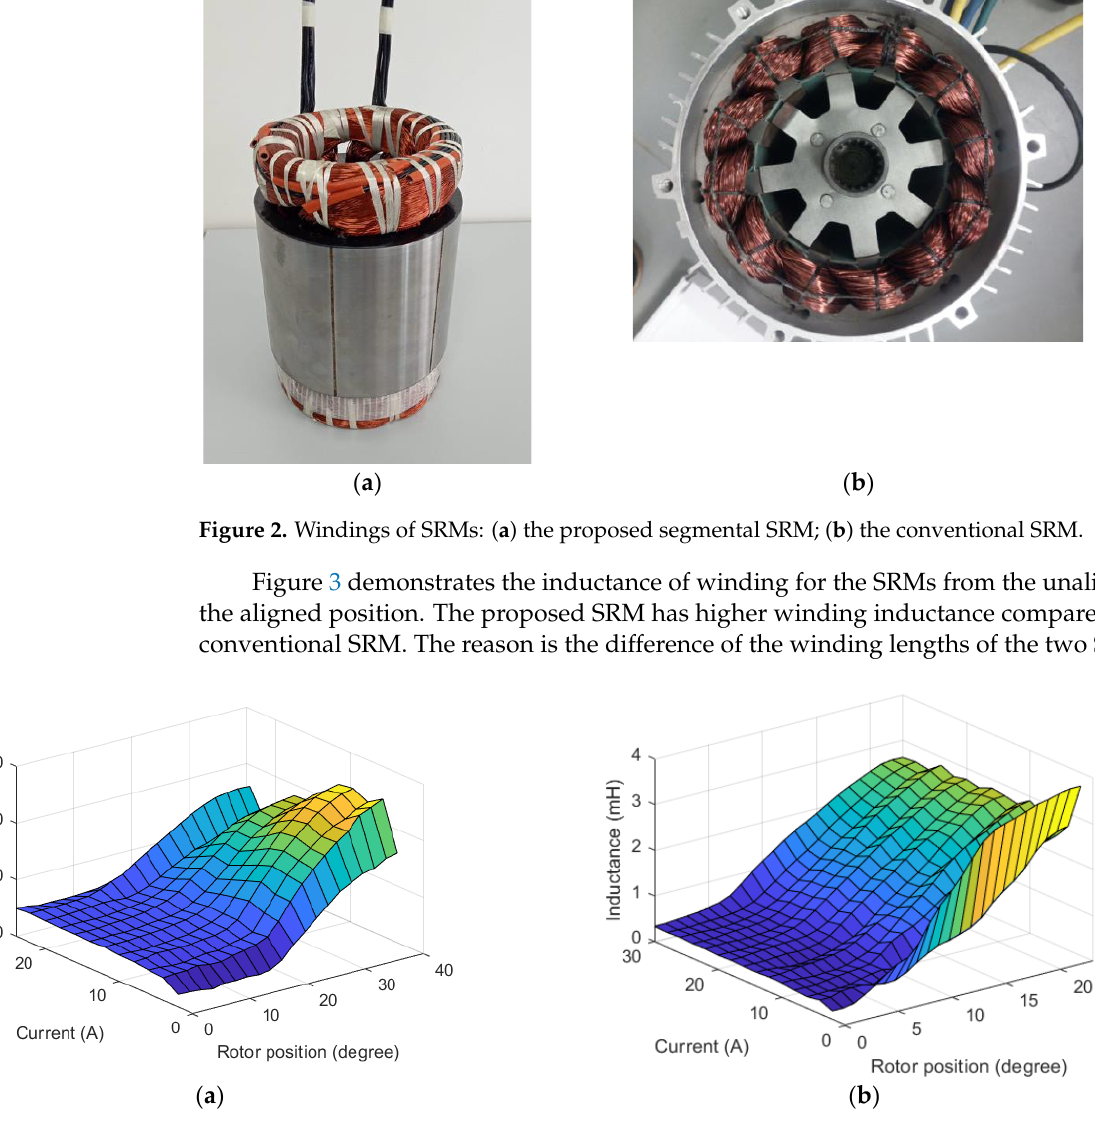
Figure 3. Measured winding inductance of SRMs: ( a ) the proposed segmental SRM; ( b ) the conven- tional SRM.